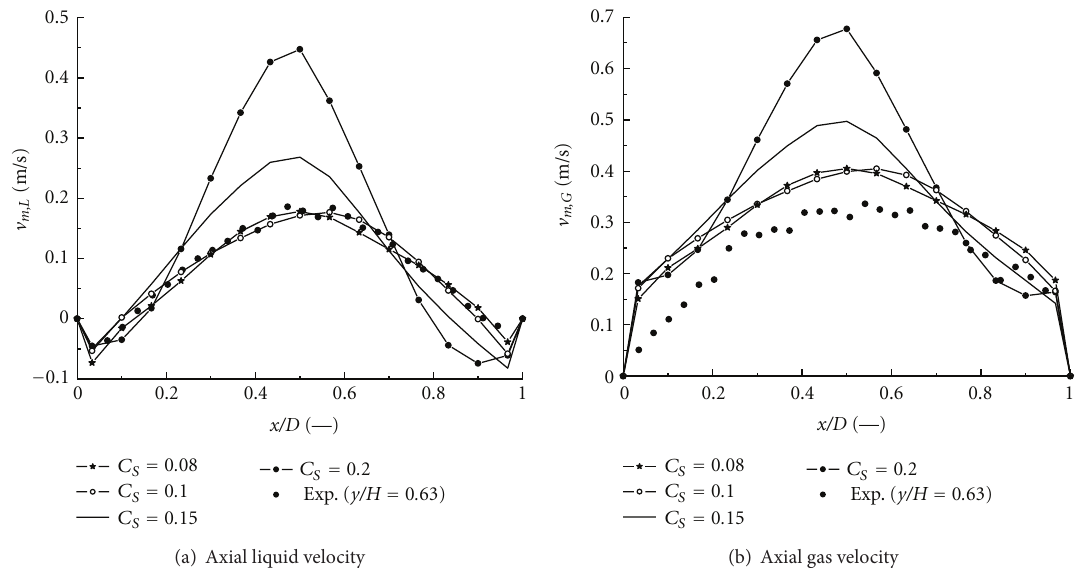
Figure 5: Comparison of the prediction and measurement of mean velocity of the both phases; the predicted profiles were obtained with different 𝐶 𝑆 values used in the SGS model (Zhang et al. [26]).